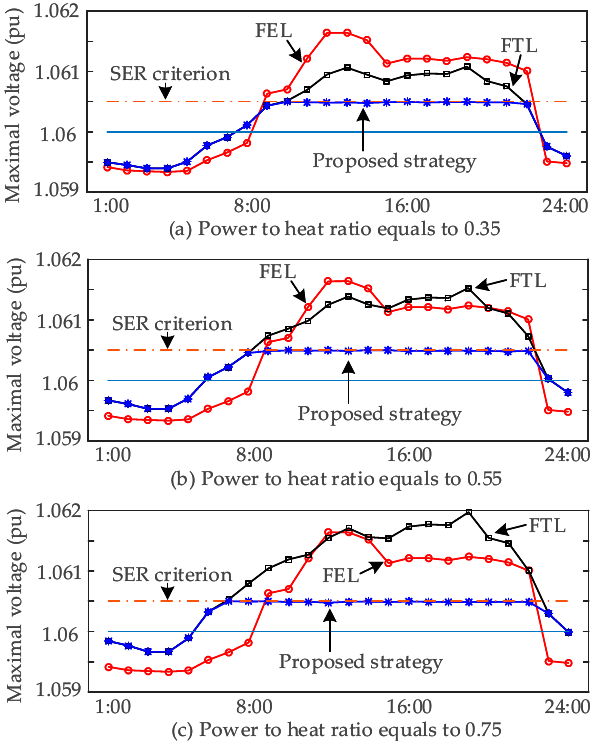
Figure 7. Maximal voltages under different control strategies in winter (power to heat ratio of CHP generation is set with diverse value, where ( a ) C = 0.35; ( b ) C = 0.55; and ( c ) C = 0.75).